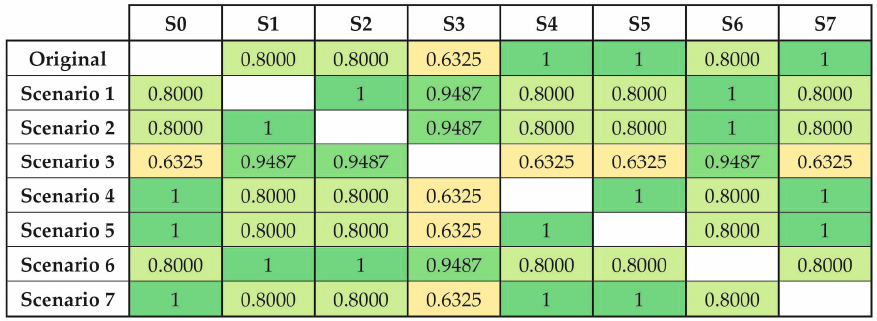
Figure 7. Application of Spearman’s correlation coefficient to the results obtained.